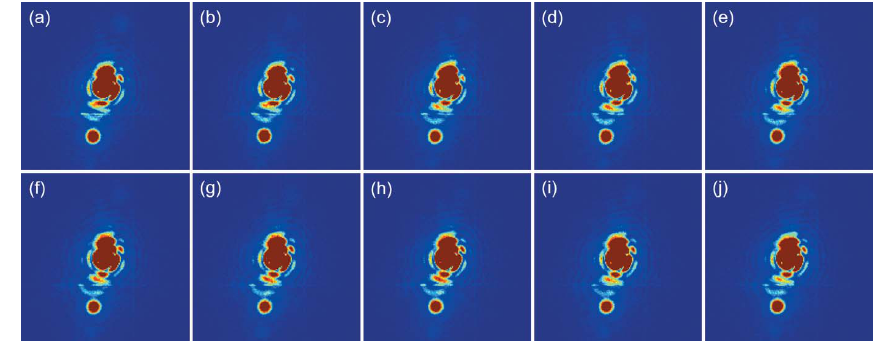
Figure 7 A series of diffraction patterns near the off-specular Au(11 (cid:2) 11) Bragg peak. The diffraction patterns of Au nanocrystals were recorded during annealing at 500 (cid:2) C. The interval is (cid:3) t ’ 13 min. Data contain 161 (cid:5) 161 pixels corresponding to (cid:3) Q = (cid:6) 0.0237 A˚ (cid:3) 1 .